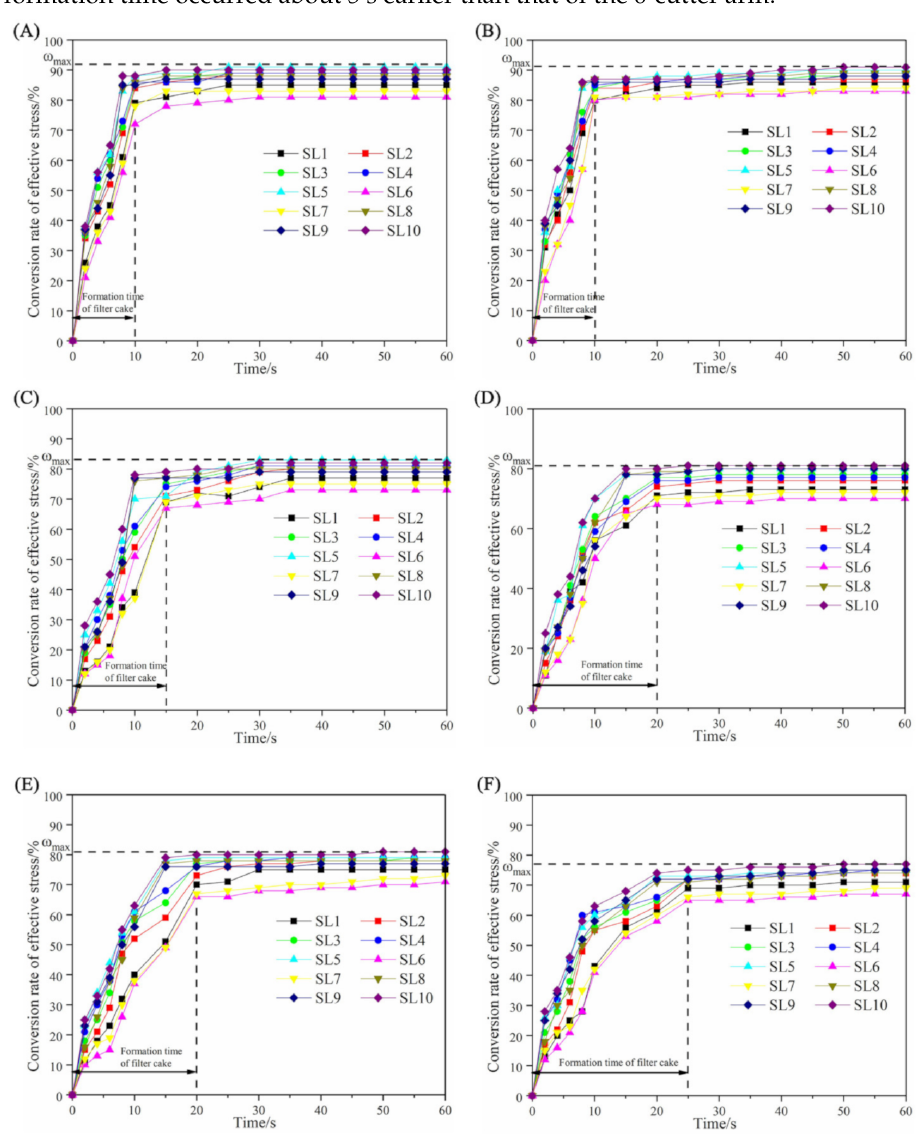
Figure 11. Variation curves of effect stress conversion: ( A ) cutter head CH1, rotation speed of cutter head = 0 rpm, ( B ) cutter head CH2, rotation speed of cutter head = 0 rpm, ( C ) cutter head CH1, rotation speed of cutter head = 0.5 rpm, ( D ) cutter head CH2, rotation speed of cutter head = 0.5 rpm, ( E ) cutter head CH1, rotation speed of cutter head = 1.0 rpm, ( F ) cutter head CH2, rotation speed of cutter head = 1.0